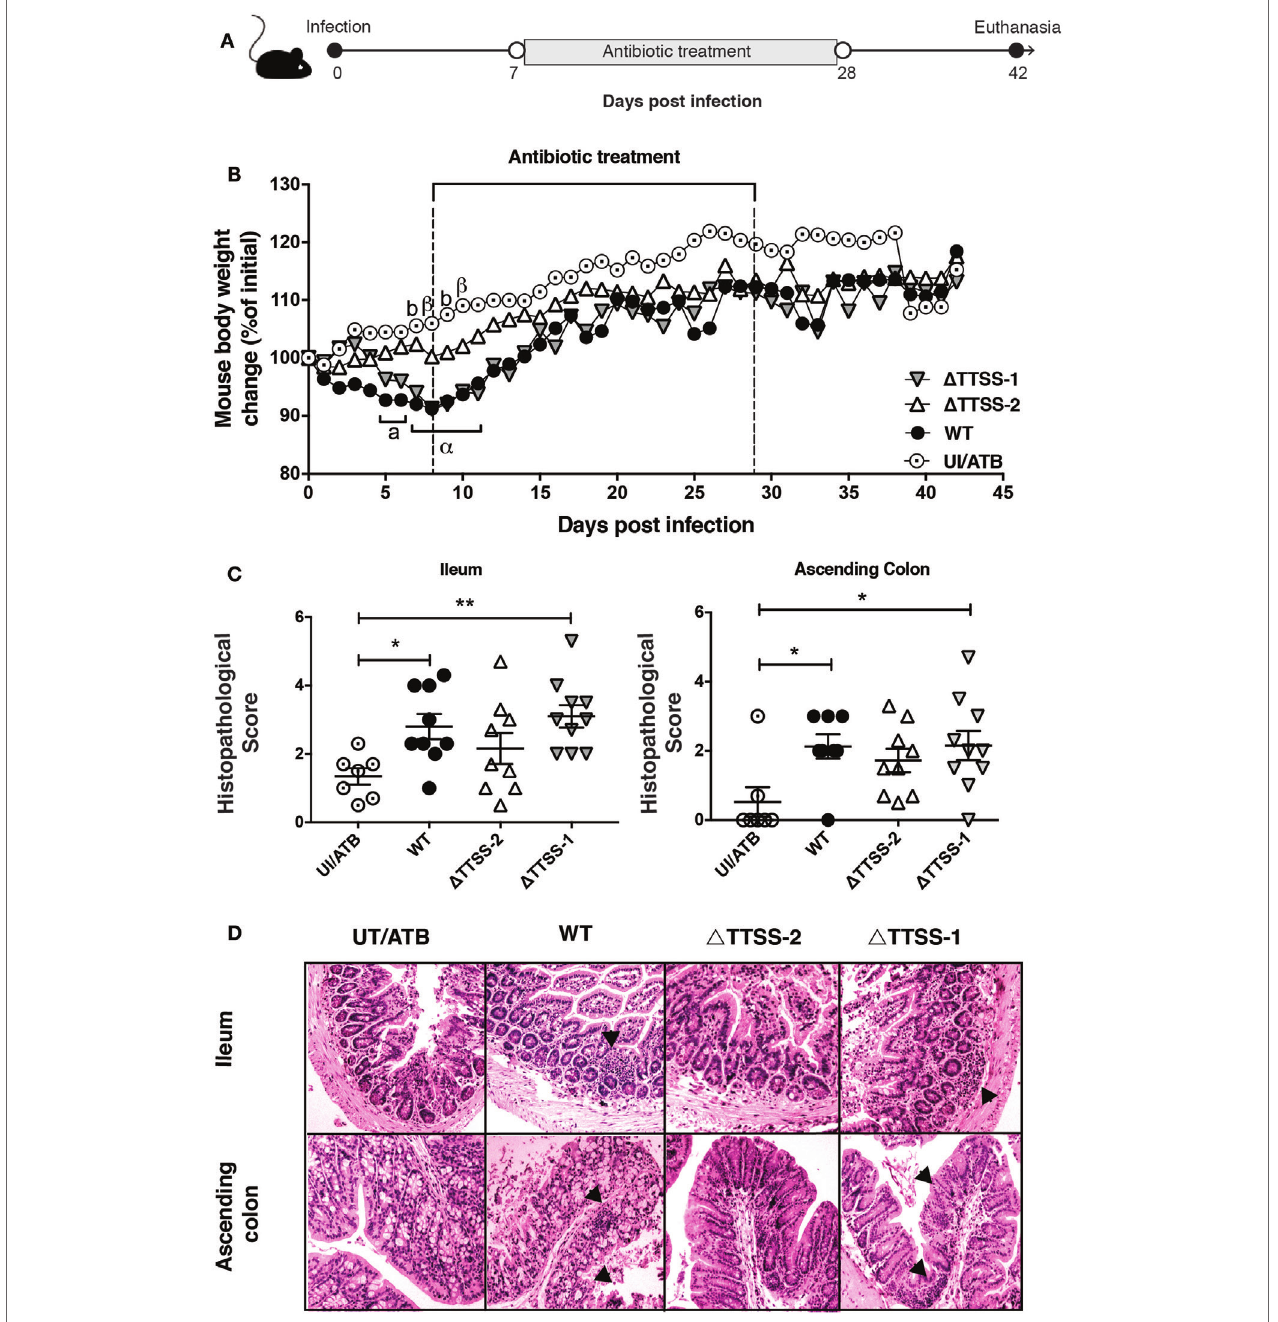
FigUre 2 | Previous Salmonella enterica serovar Typhimurium ( S. Typhimurium) infection increase the susceptibility of spontaneous intestinal inflammation of interleukin (IL)-10 − / − mice. (a) IL-10 − / − mice were orally infected with 1 × 10 6 CFU of S. Typhimurium (STM) wild type (WT), Δ TTSS-1, or Δ TTSS-2. Seven days post-infection (days p.i.) mice were orally treated with enrofloxacin (2 mg/ml) for 3 weeks, left untreated for 14 days and euthanized to evaluate spontaneous intestinal inflammation. (B) Body weight were recorded on a daily basis for 42 days after infection. (c) Average histopathology score for ileum and ascending colon of 6–10 IL-10 − / − mice included in each group. (D) Representative images of on the intestines of IL-10 − / − mice infected with S. Typhimurium WT, Δ TTSS-1, or Δ TTSS-2 (4 µm ileum and ascending colon section stained with H&E and observed in optical microscope at 10 × magnification). Body weight changes were analyzed using two-way ANOVA with Dunnetts post-test. Mice infected with WT (a, α ) and TTSS-1 (b, β ) were compared with mice uninfected and treated with antibiotics (UI/ATB). Data shown are mean ± SEM of three independent experiment with 8 mice uninfected; 10 mice infected with WT strain; 10 mice infected with Δ TTSS-1 strain; and 9 mice infected with Δ TTSS-2 strain. Statistical significance was indicated by letters: a, b: * P < 0.05; α , β : ** P < 0.01. Histopathology score was analyzed by one-way ANOVA with Kruskal–Wallis post-test. Data shown are mean ± SEM * P < 0.05; compared with uninfected mice. Tissue damage and inflammatory infiltration are indicated